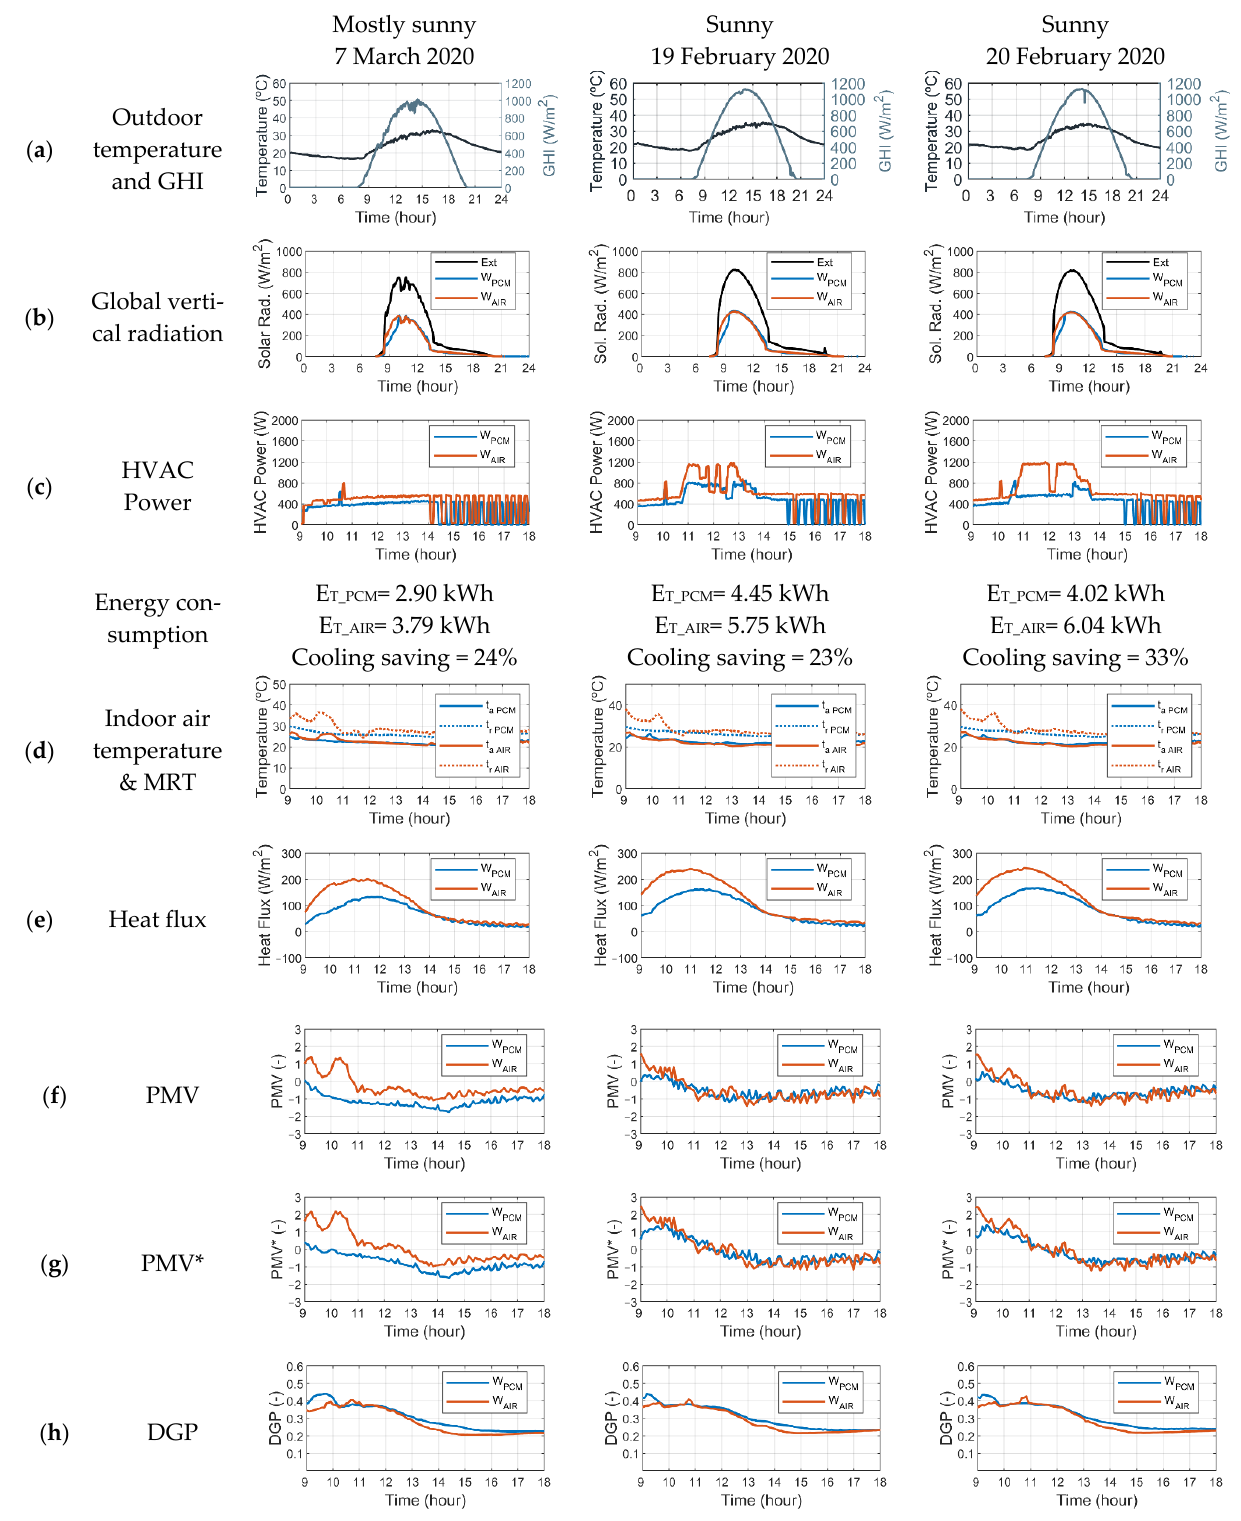
Figure 9. Results for representative days of summer. ( a ) Outdoor temperature and global horizontal radiation (GHI); ( b ) global vertical radiation; ( c ) HVAC power and energy consumption; ( d ) indoor air temperature & mean radiant tempera- ture (MRT); ( e ) heat flux; ( f ) PMV; ( g ) PMV*; ( h ) DGP.